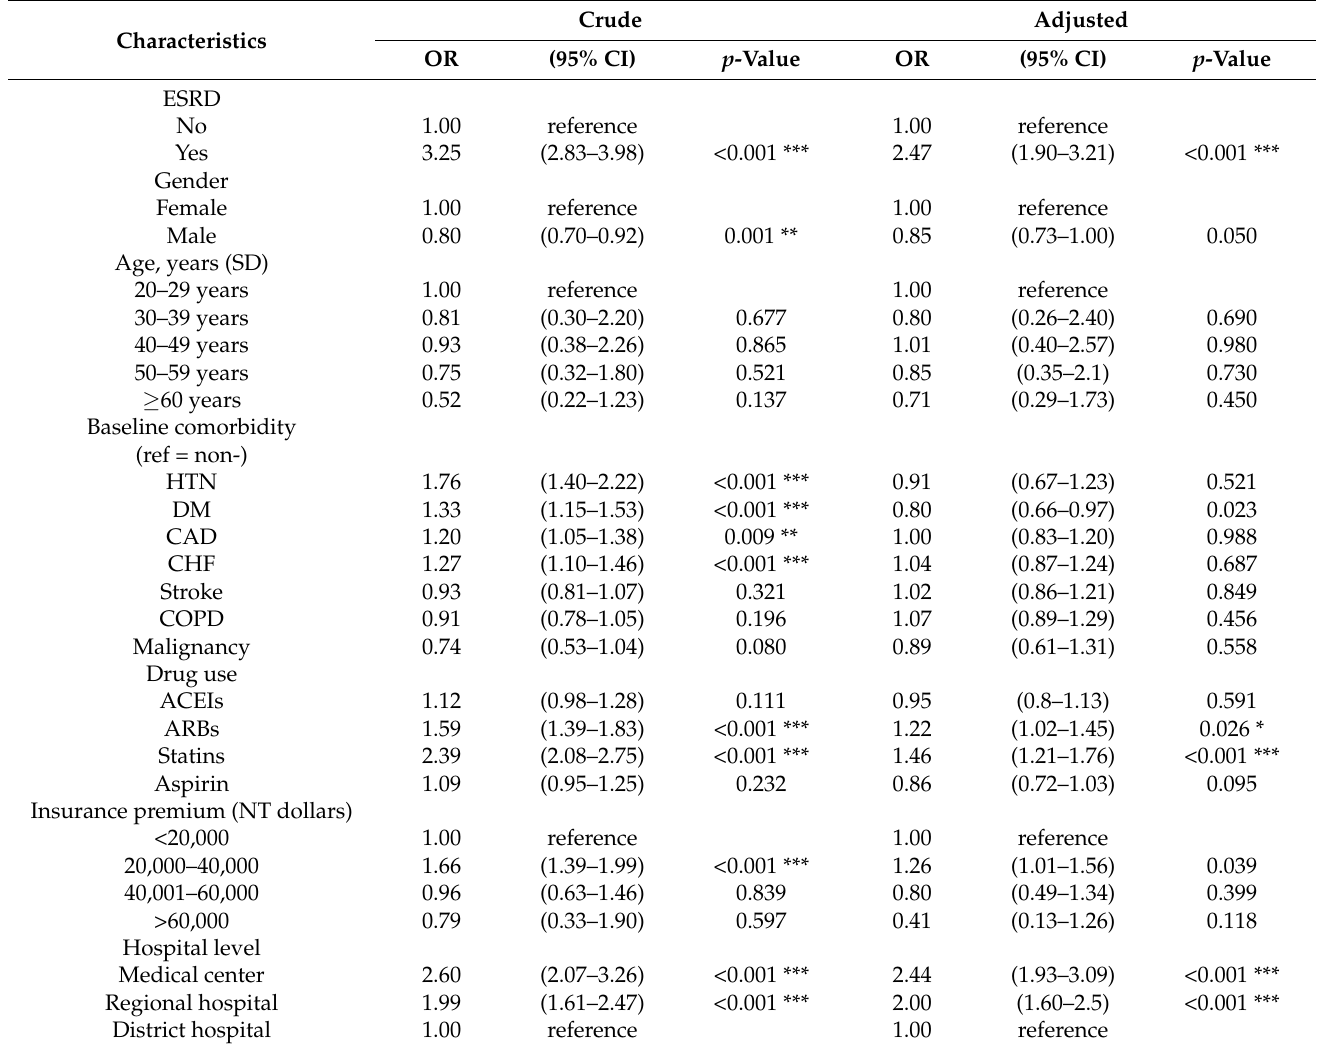
Table 3. Logistic regression model measured odds ratio with 95% confidence interval of ROSC associated with ESRD undergoing hemodialysis and other variables in OHCA